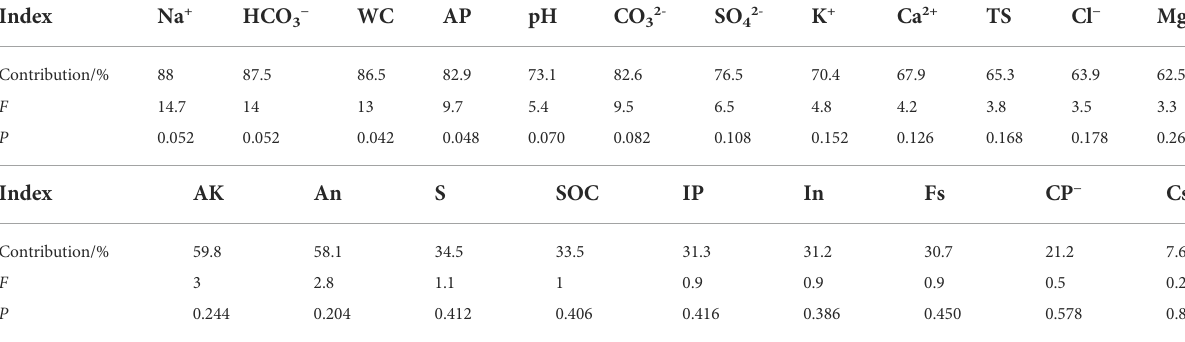
TABLE 5 Contributions of physical and chemical indexes of soil according to redundancy analysis.